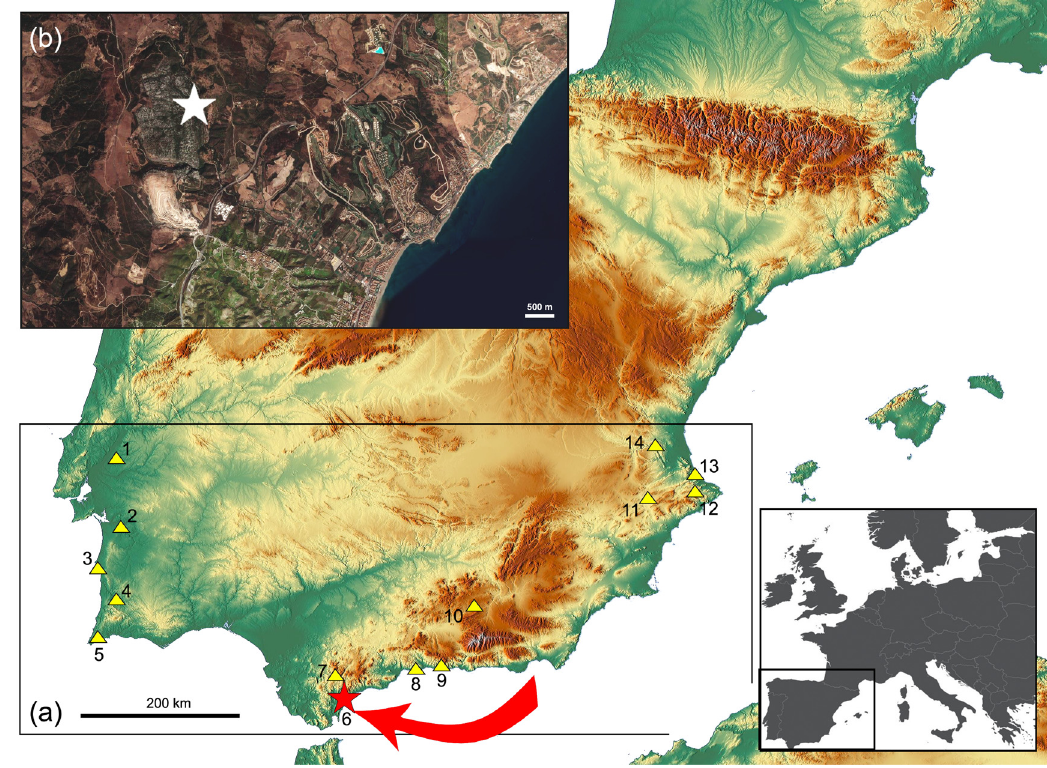
Figure 1: ( a ) Iberian Peninsula, indicating southern sites with published Mesolithic human remains. 1: Muge shell middens ( Moita do Sebastião, Cabeço da Arruda, Cabeço do Amoreira, Fonte do Padre Pedro, Flor da Beira, and Cova da Onça, Ribatejo ) ; 2: Sado sites ( Cabeço das Amoreiras, Arapouco, Cabeço do Pez, Alentejo ) ; 3: Samouqueira ( Alentejo ) ; 4: Fiais ( Alentejo ) ; 5: Vale Boi ( Algarve ) ; 6: Sima Hedionda II/IV ( Casares Málaga ) ; 7: Cueva del Esqueleto ( Cortes de la Frontera, Málaga ) ; 8:, Cueva del Higuerón - Tesoro ( Cala del Moral, Málaga ) ; 9: Cueva de Nerja ( Maro, Málaga ) ; 10: Cueva de la Cariguela ( Píñar, Granada ) ; 11: Casa Corona ( Villena, Alicante ) ; 12: Coves de Santa Maira ( Castell de Castells, Alicante ) ; and 13: El Collado ( Oliva, Valencia ) . ( b ) Aerial view of Utrera Karstic formation, with Sima Hedionda II/IV site ( white star ) ( Casares, Málaga )